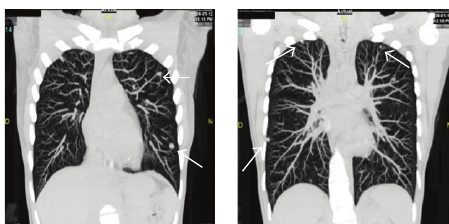
Figure 2: Pulmonary nodules (arrows) in both hemithoraces on a CT scan.